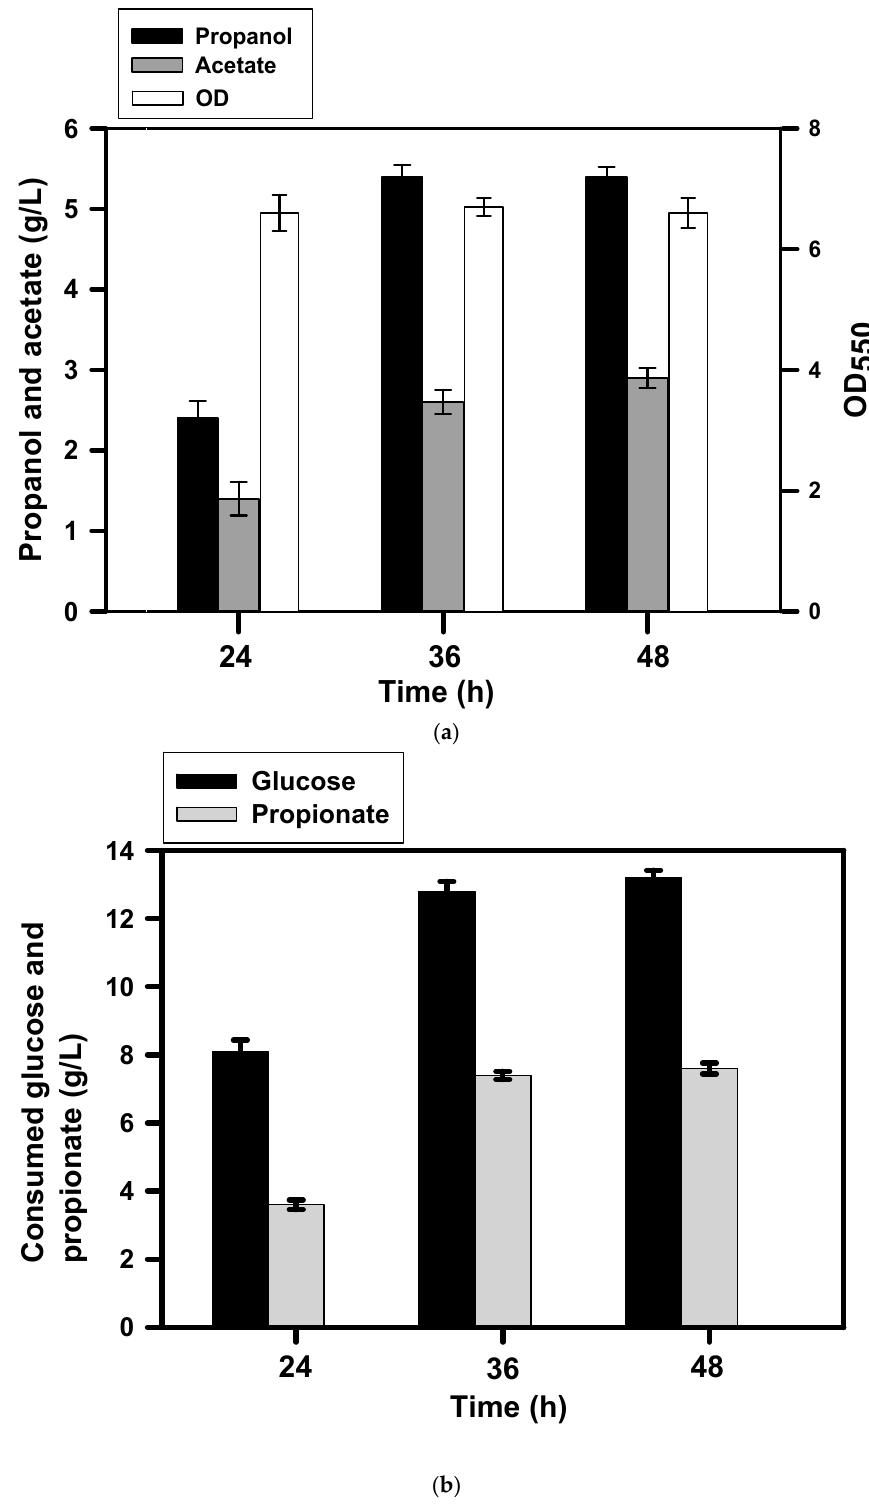
Figure 4. Production of 1-propanol by the genetically-modified strain. Derived from BuT-3E strain, BuT-3EP strain was employed for the fermentation in the presence of glucose (10 g/L) and propionate (4 g/L). At 24 h, the substrate containing glucose (10 g/L) and propionate (4 g/L) was added to the culture medium and the fermentation result was analyzed at a predetermined interval. The experiment was conducted in triplicate. The fermentation products and the cell density (OD 550 ) were determined at the end of the fermentation ( a ). The consumption of glucose and fatty acids were measured for further analyses ( b